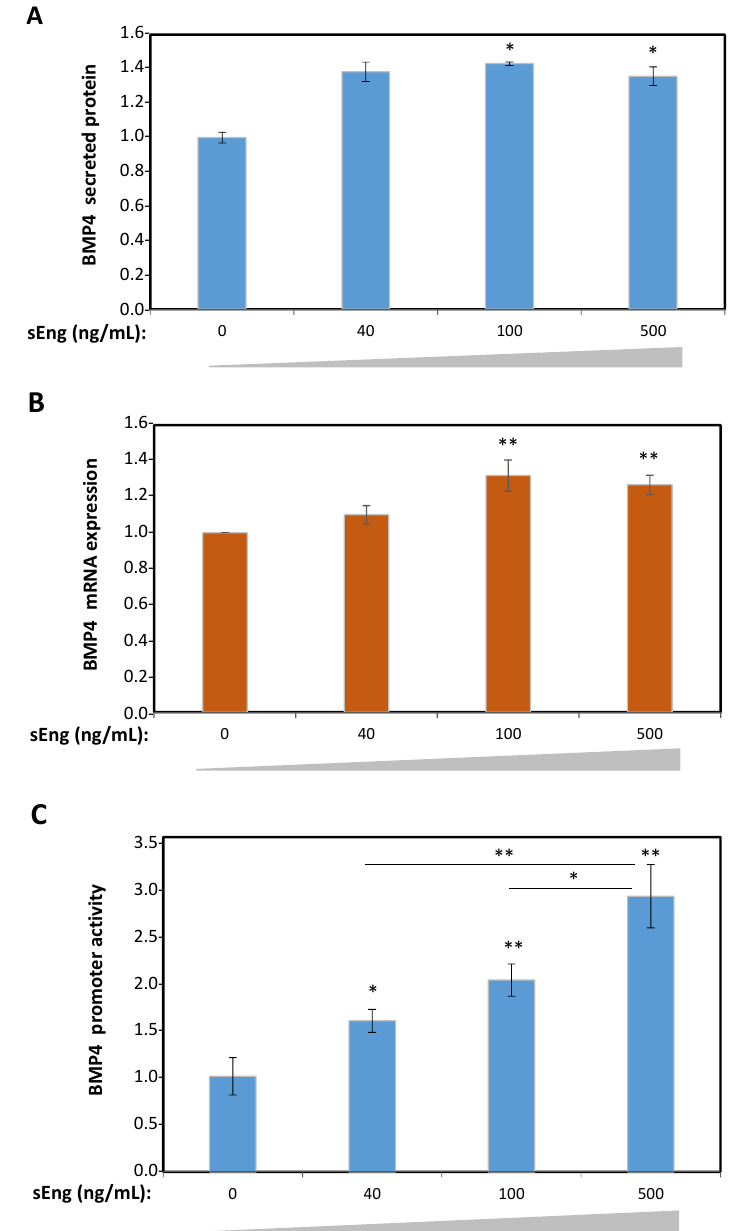
Figure 2. BMP4 expression upon in vitro treatment of cells with sEng. ( A , B ) HUVECs were treated with sEng at the indicated concentrations. Protein levels of BMP4 secreted into the medium were determined by ELISA and normalized to control ( A ). Transcript levels of BMP4 were measured by qRT-PCR and values normalized to the control condition ( B ). ( C ) sEng transactivates the BMP4 promoter. HEK293T cells were transiently transfected with the pEZX-PG04.1 vector encoding the Gaussia luciferase driven by the human BMP4 promoter. Cell transfections were performed in the presence of increasing concentrations of sEng and after forty-eight hours, the luciferase activity of cell lysates was measured by luminometry. Unless otherwise indicated, p values are referred to the control condition. (* p < 0.05; ** p <